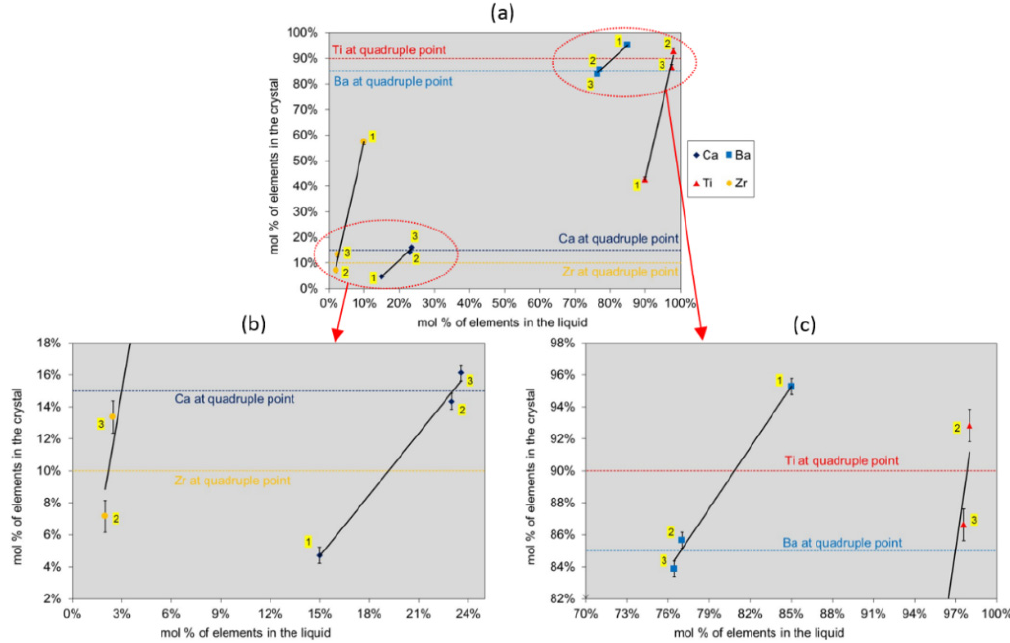
Figure 3. Segregation of elements in BCTZ for the three growth attempts (number of the attempt is written with a yellow background). ( a ) The molar concentrations of elements per site for BCTZ single